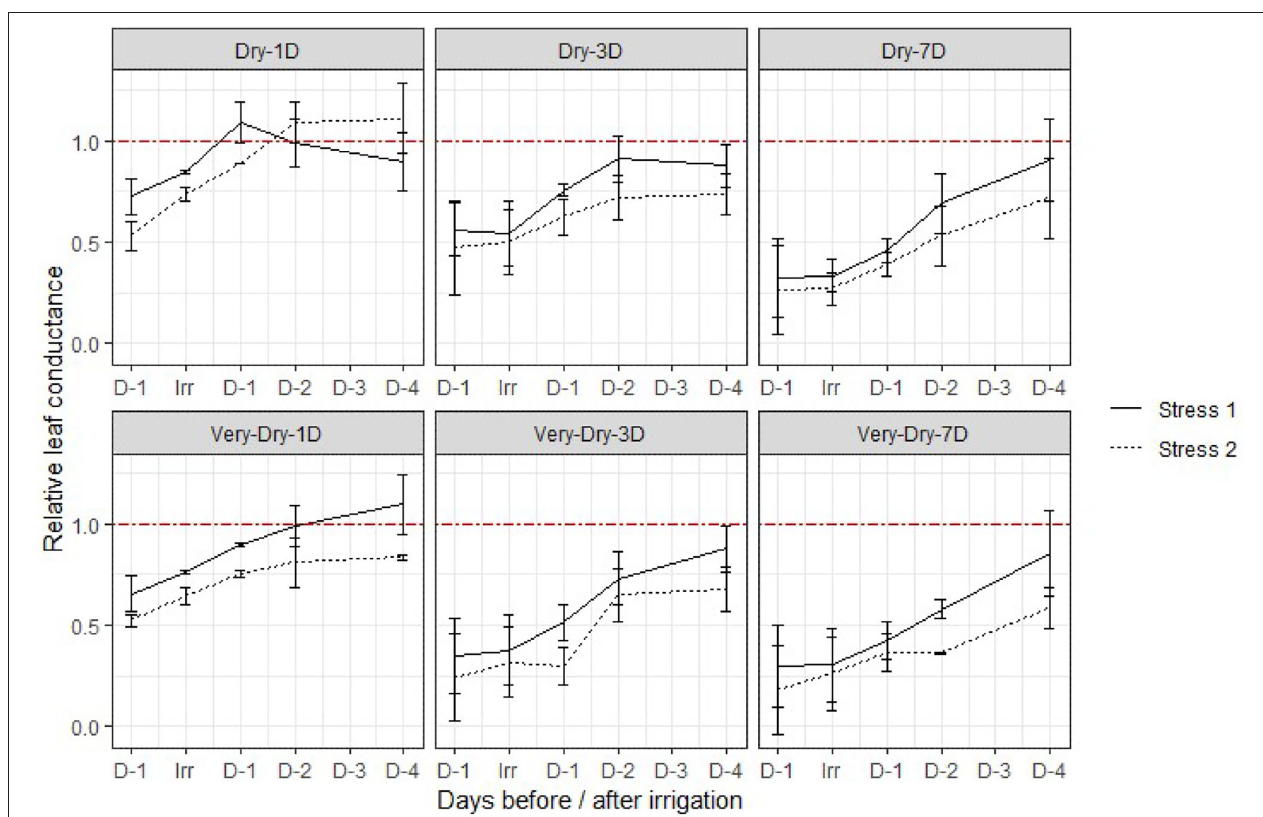
FIGURE 2 | Evolution of relative stomatal conductance (replicate/control) for the different irrigation treatments over the period from the day before and up to 4 days after irrigation treatments application for the summer 2019 experiment. The error bars represent the standard deviation around the mean for the four replicates of a same treatment. The red dashed line ( —-) represents the threshold from which the recovery of the treatments is complete compared to the control measured at the same time. The values above the red dashed line represent an increase in stomatal conductance of treatments compared to the control and those below a deficiency. D − 1, D+1, D+2, D+3, D+4 on the X axis represent the number of days before ( − ) and after (+) application of irrigation. Irr is the day that irrigation is